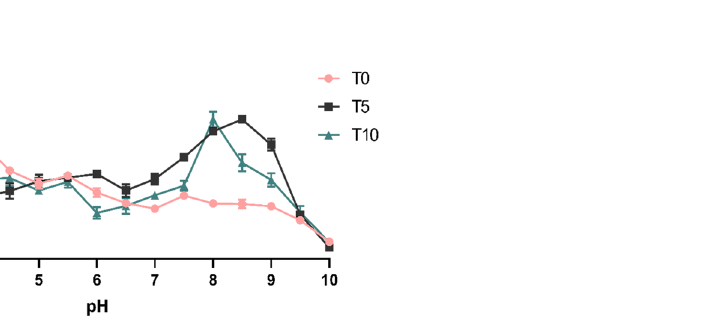
Figure 8. Statistically significant changes in the abundance of proteins with proteolytic activity based on LC– MS/MS quantification. The heat map shows statistically significant changes in protein abundance at a single gene resolution. Genes which are not expressed at a particular time point are coloured in grey. Differences in protein expression are shown as Z-score values. Gene names shown at x-axis begin with the peptidase family code; catalytic classes are shown above the heatmap (C—cysteine peptidases, M—metallopeptidases, S—serine peptidases, T—threonine peptidases).